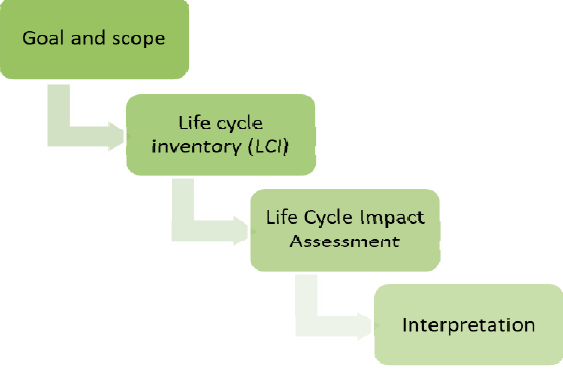
Figure 1. Stages of life cycle assessment based on [35].